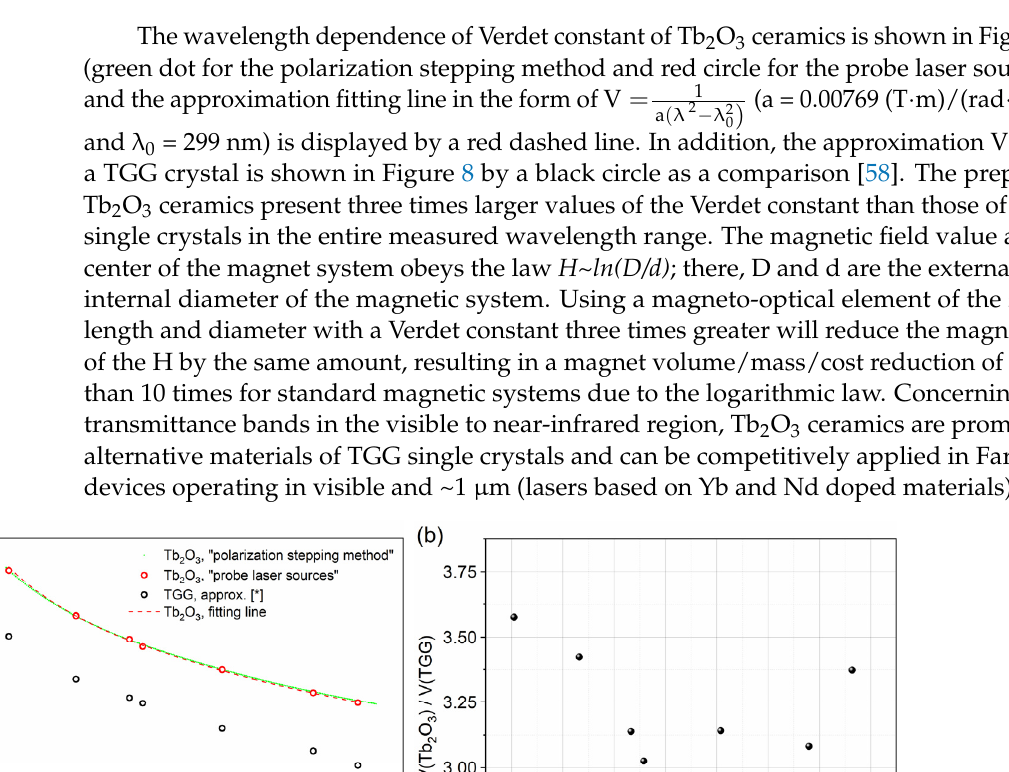
Figure 7. Inverse of the Verdet constant (1/V) as a function of squared wavelength ( λ 2 ) for the Tb 2 O 3 ceramics.